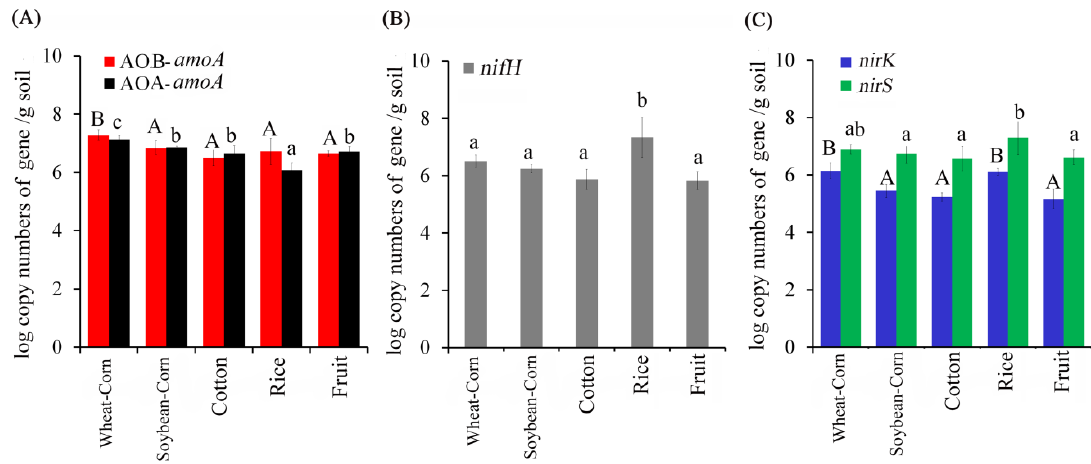
Figure 5. Number of AOA and AOB amoA gene copies ( A ), nifH gene copies ( B ) and nirK and nirS ( C )